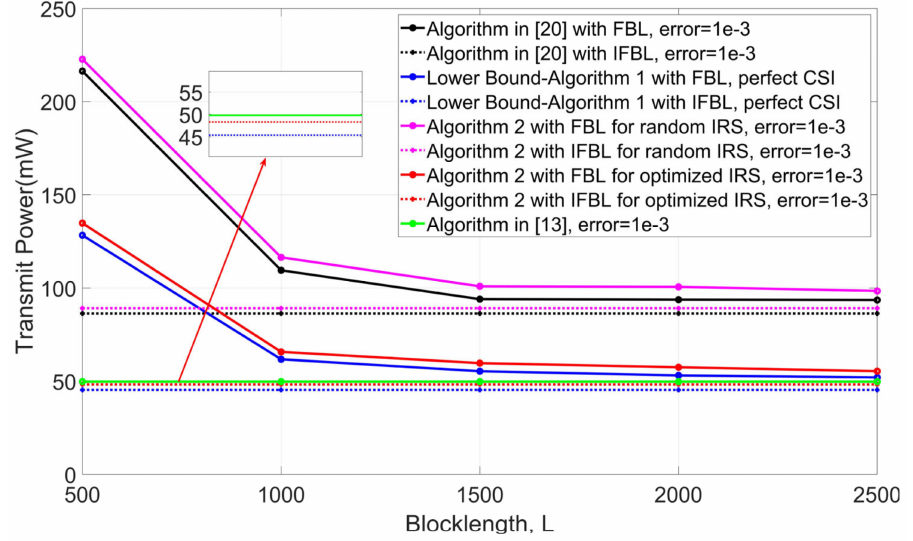
Figure 7. The effectiveness of the proposed algorithm under different numbers of the blocklength.